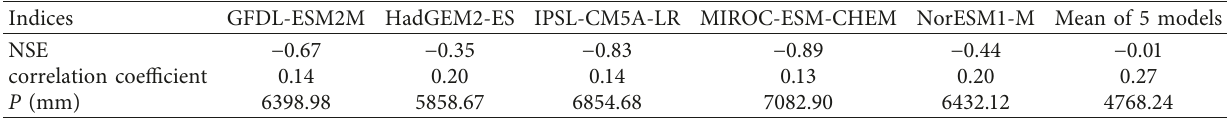
Table 8: Comparison of simulated and measured values of precipitation in Guizhou from 1961 to 2000.